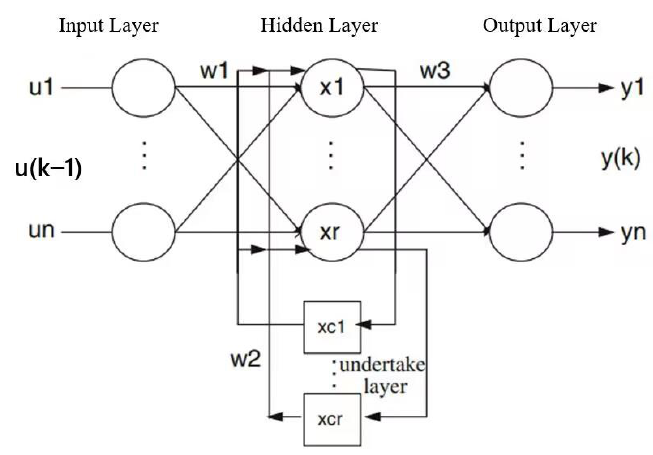
Figure 4. Schematic diagram of Elman model structure.